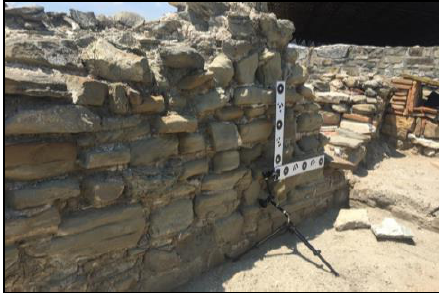
Figure 13. Set-Up for L-Target